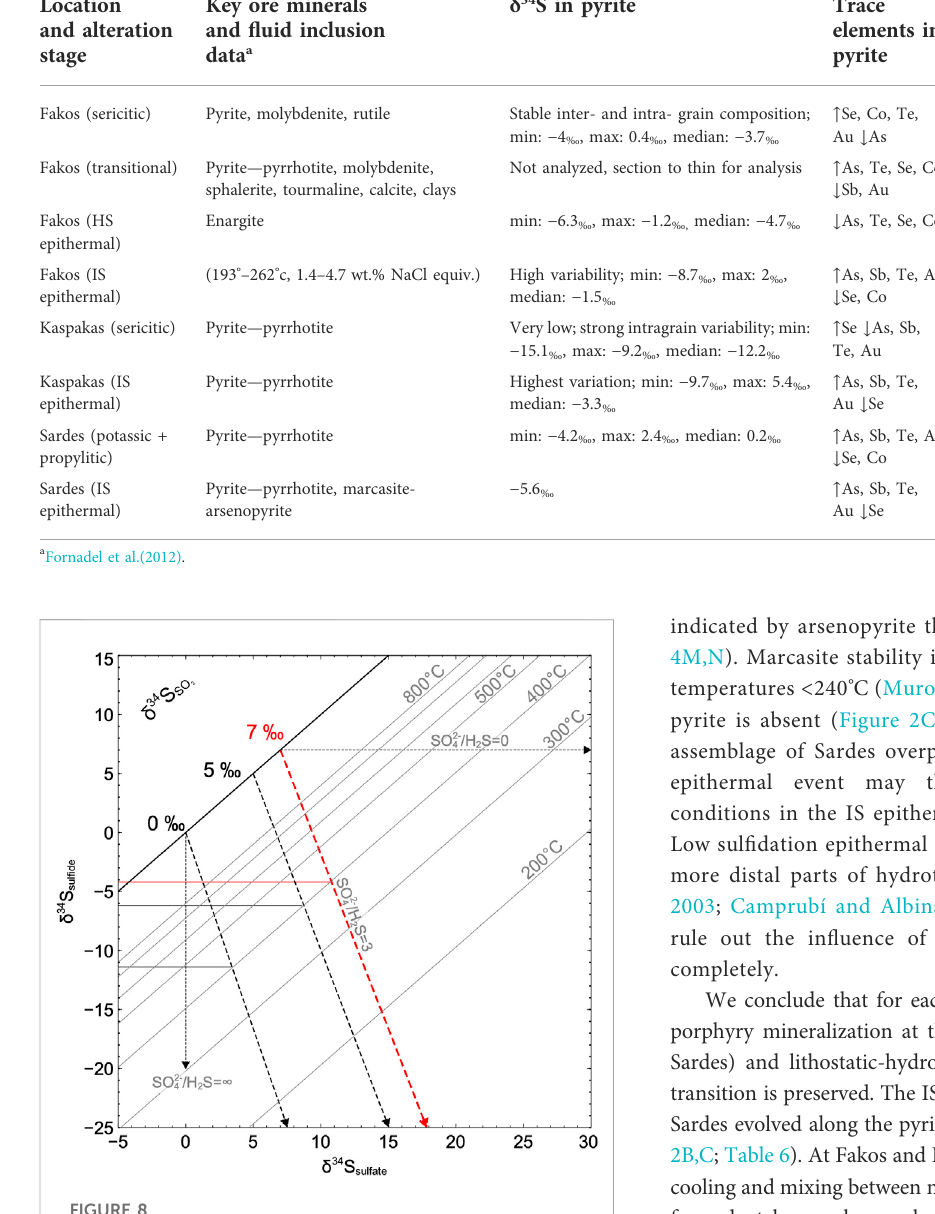
TABLE 6 Overview of key characteristics and processes at the investigated hydrothermal stages of Fakos, Kaspakas and Sardes. Location and alteration